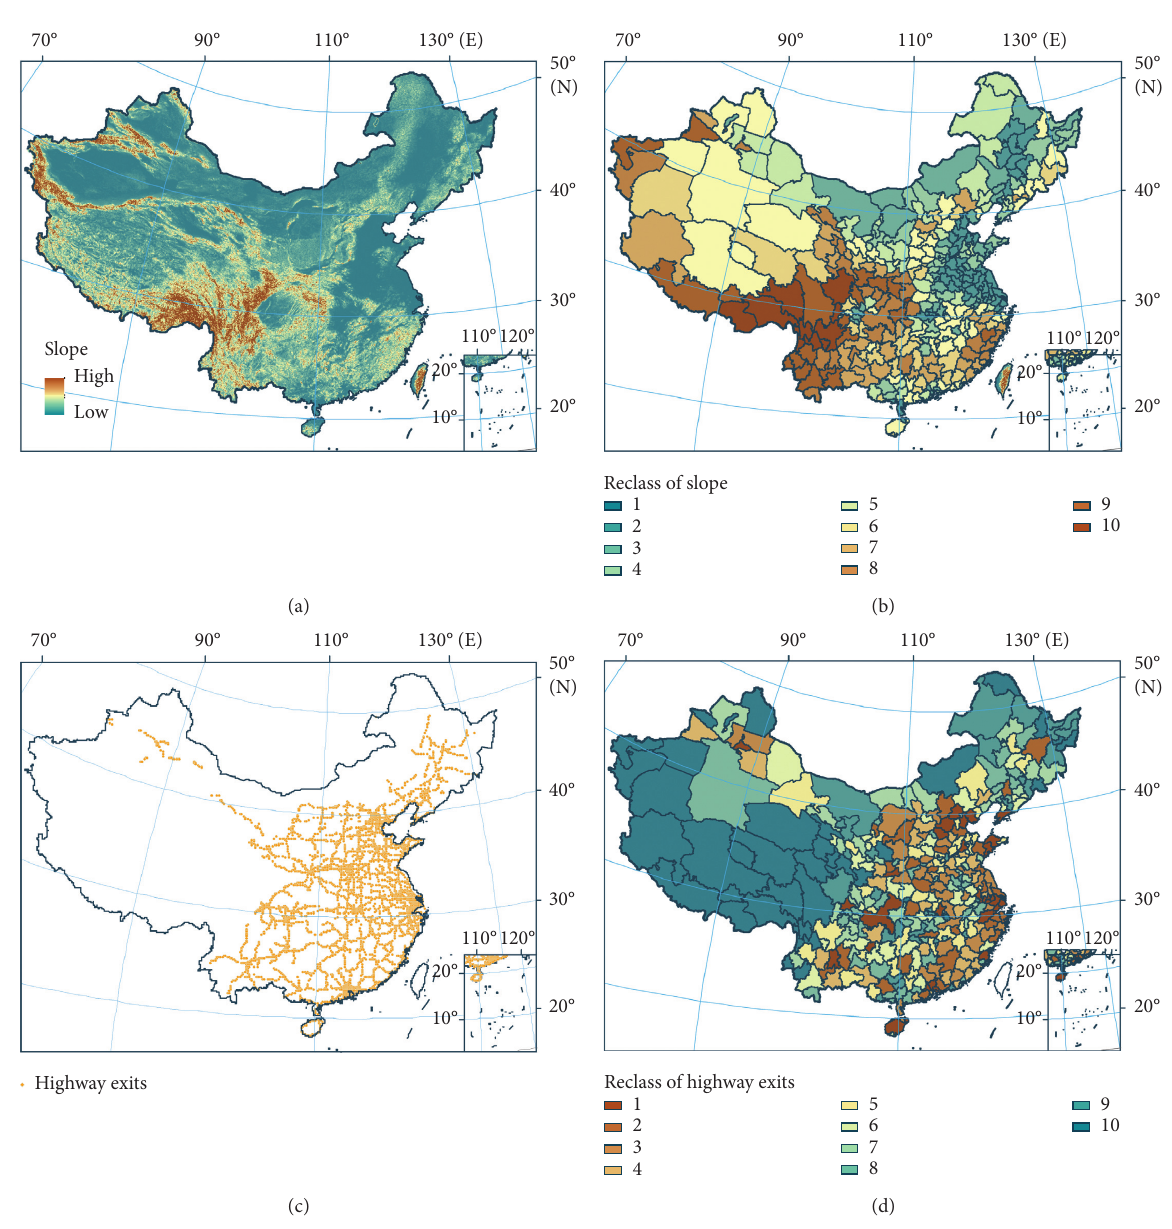
Figure 1: Example of data processing: (a) slope (gridded data), (b) results of slope processing, (c) highway exits (vector data), and (d) results of highway exits